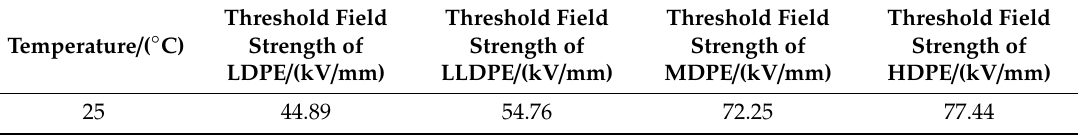
Table 5. Field strength of the four different density polyethylenes in the high field strength region from body effect to electrode effect.